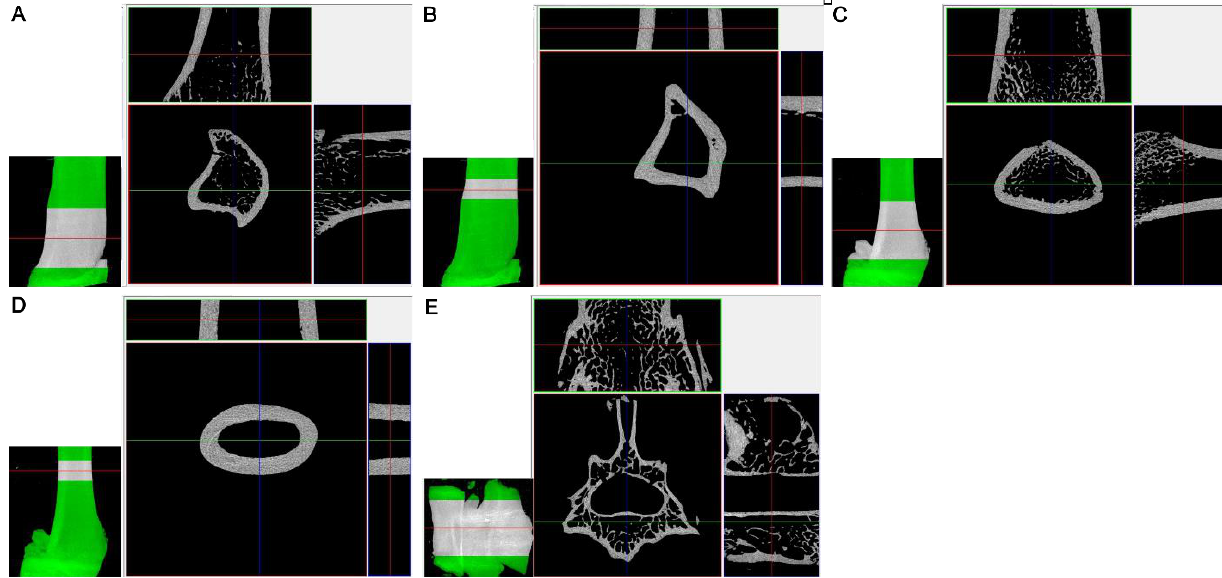
Figure 4. Analyzed regions of interest (ROI) of the tibia (proximal metaphysis), the femur (distal metaphysis) and the third lumbar vertebra. ( A ) ROI of the cancellous bone of tibia; ( B ) ROI of the cortical bone of tibia; ( C ) ROI of the cancellous bone of femur; ( D ) ROI of the cortical bone of femur; ( E ) ROI of the cancellous tissue of vertebra.